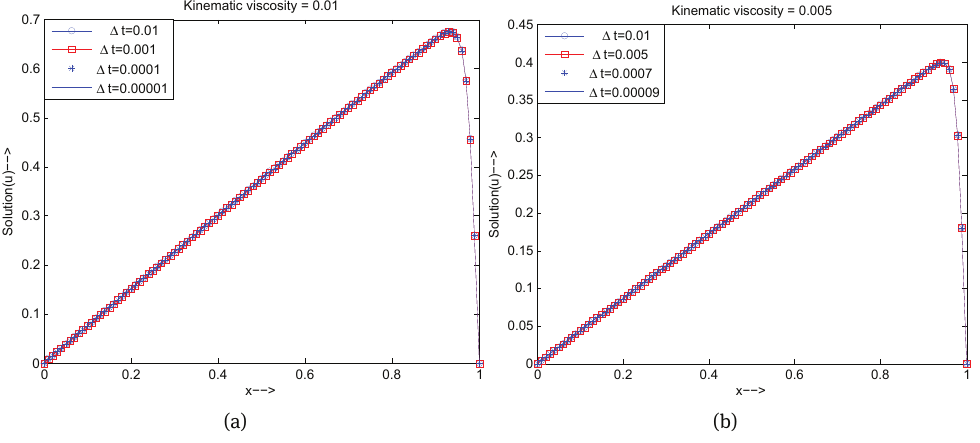
Fig. 19: Solution curve for Example 1 for different values of Δt with Δx = 0.01 (a) ν = 0.01 , T = 1 (b) ν = 0.005 , T = 2 .